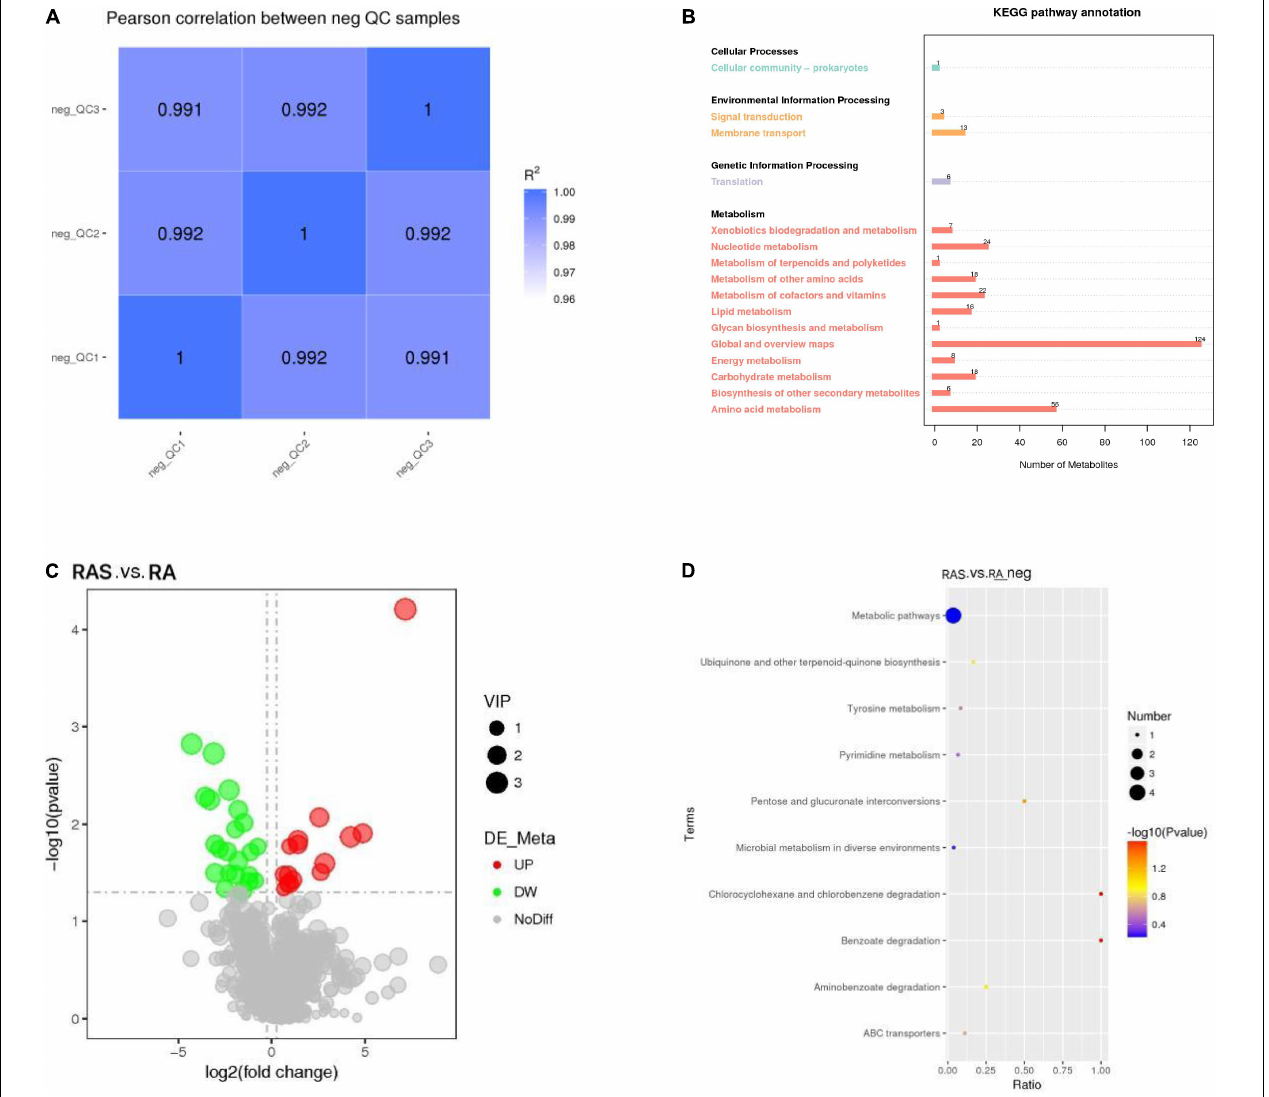
FIGURE 2 | (A) QC samples correlation analysis; (B) The Kyoto Encyclopedia of Genes and Genomes (KEGG) pathway annotation; (C) The volcano plot of difference metabolites; (D) enrichment of differential metabolites in KEGG pathways. Rich factor, ratio of the proportion of differential metabolites to the proportion of all metabolites in the pathway; the size of the dots in the graph represents the number of distinct metabolites enriched in the corresponding